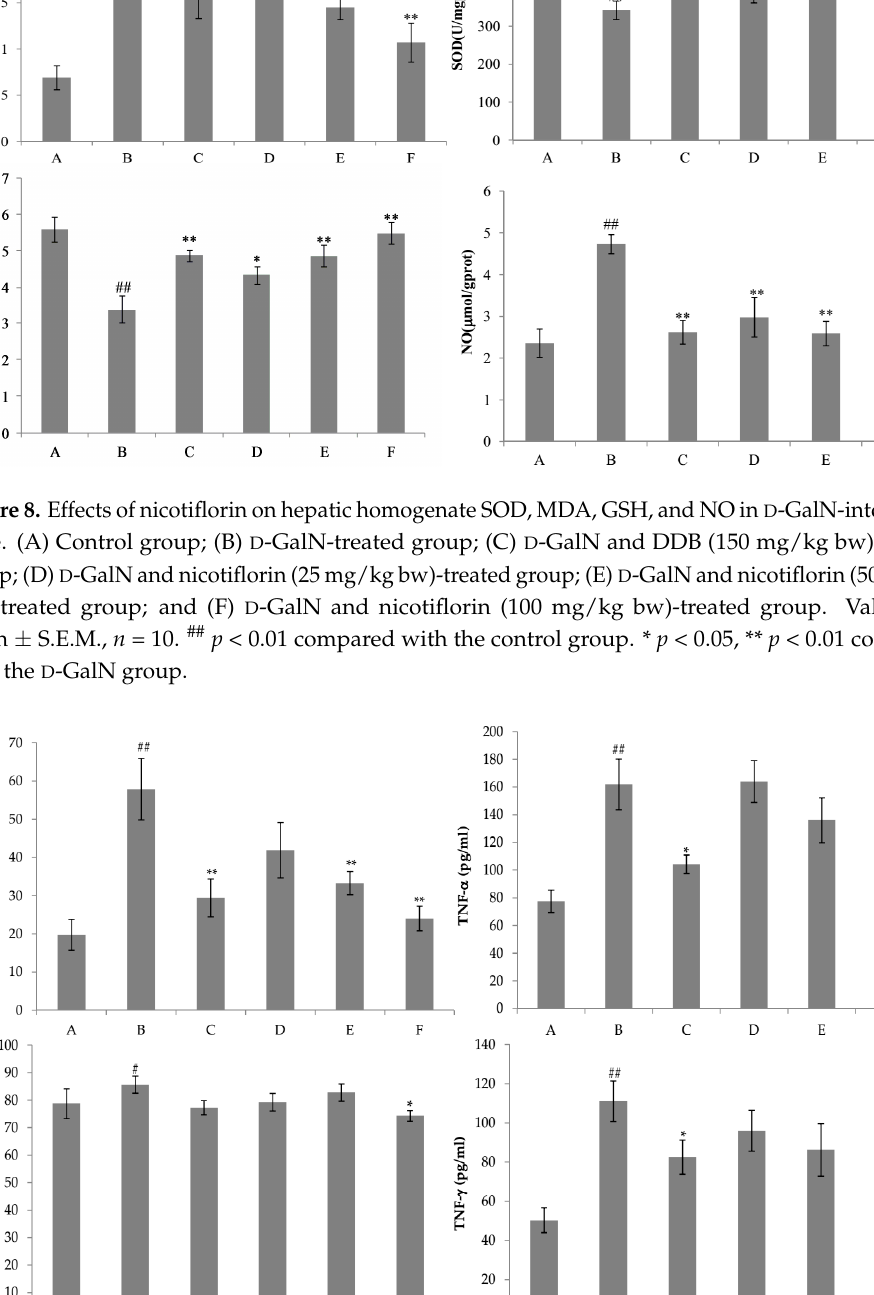
Figure 9. Effects of nicotiflorin on the serum IL-1 β , TNF- α , IL-6, and IFN- γ in D -GalN-intoxicated mice. (A) Control group; (B) D -GalN-treated group; (C) D -GalN and DDB (150 mg/kg)-treated group;